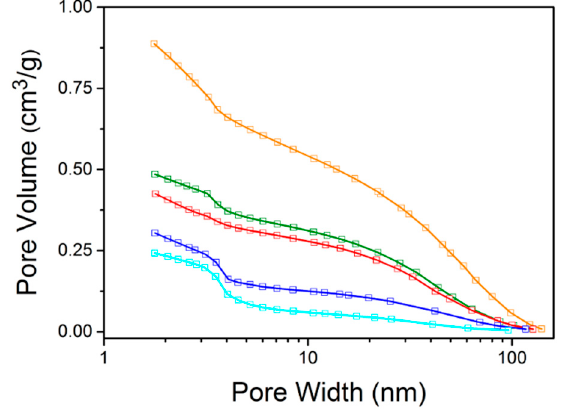
Figure 8. Cumulative pore volume (cm 3 / g) vs. pore width (nm) calculated by BJH model on the desorption branch of isotherms for di ff erent TiO 2 samples: TiO 2 _0 h (orange line), TiO 2 _2 h (green line), TiO 2 _8 h (red line), TiO 2 _16 h (blue line), TiO 2 _24 h (light blue line).